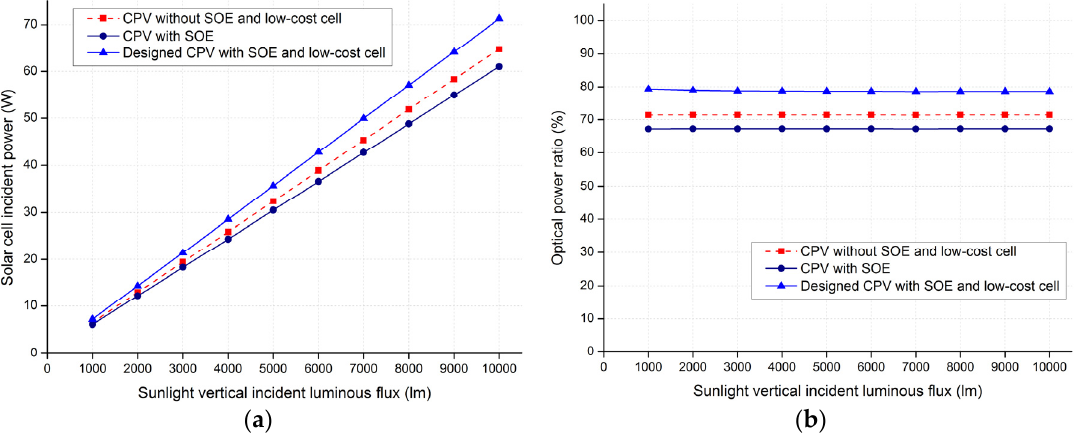
Figure 12. ( a ) comparison of incident solar power received at the solar cells of CPV units; and ( b ) comparison of the optical power ratio between CPV units.